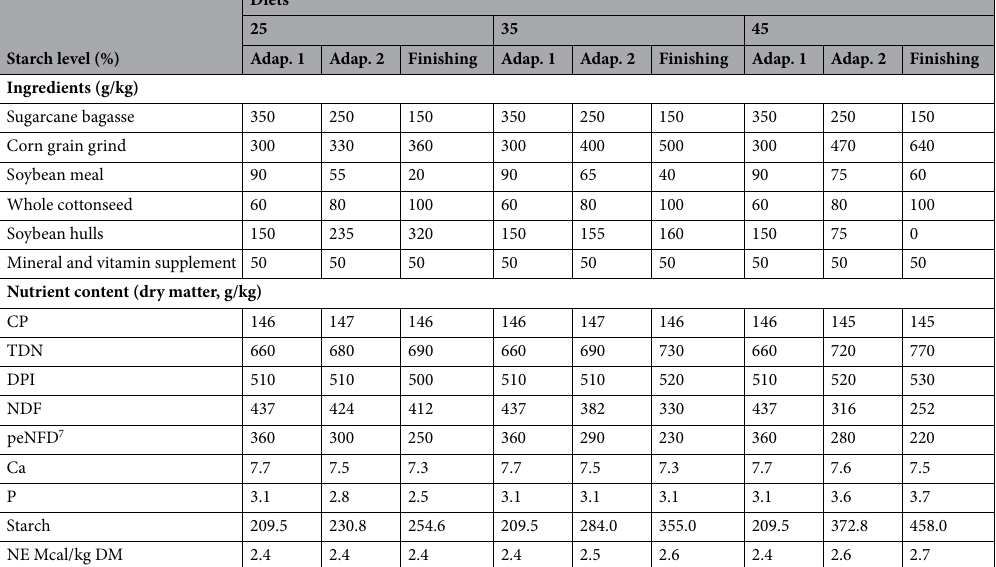
Table 4. Aining increasing starch levels (25, 35, and 45%) and additives (monensin, blend of essential oil + exogenous α-amylase) in diets for Nellore cattle feedlot. Adap 1 adaptation 1, 0–7 days, Adap 2 adaptation 2, 7–14 days, 14–92 days, CP Crude protein, TDN total digestible nutrients, DPI digestible protein intake, NDF Neutral detergent fiber, peNFD physically effective neutral detergent fiber, Ca calcium, P phosphor, NE net